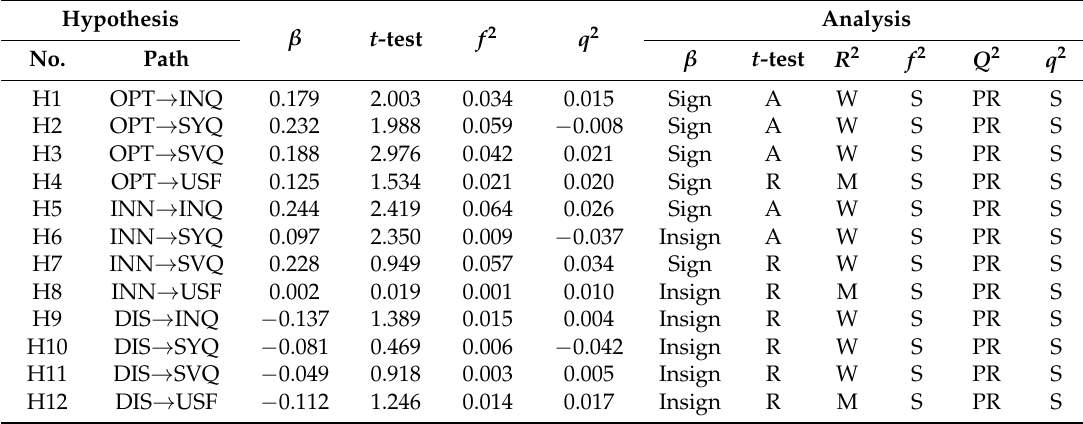
Figure 5. Results of hypothetical assessment with 13 hypothesis rejections. Table 7. Results of structural model